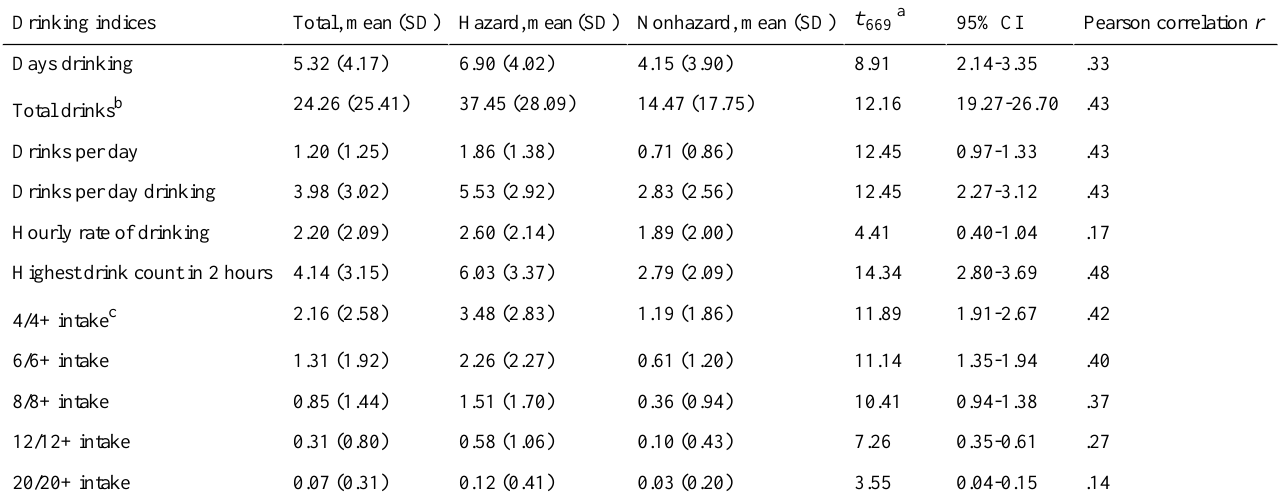
Table 2. Average alcohol intake indices as recorded via CNLab-A app (21 days), including hazard (n=286) and nonhazard (n=385) group totals and